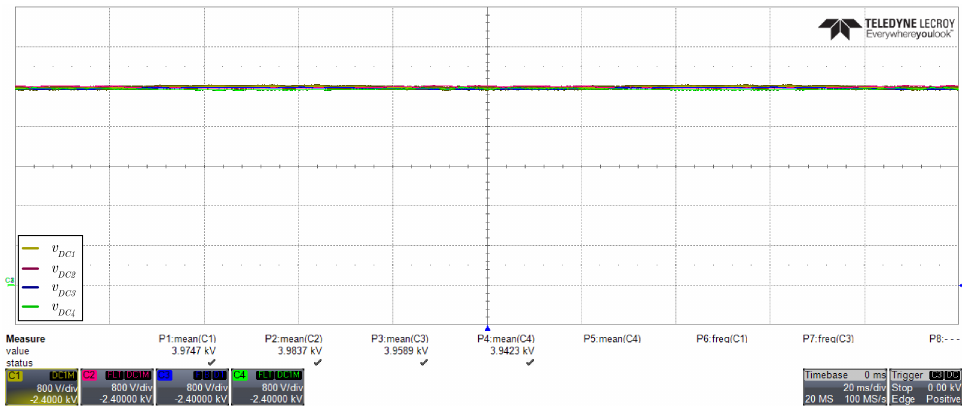
Figure 10. Sub-module DC voltage from four different converter arms.